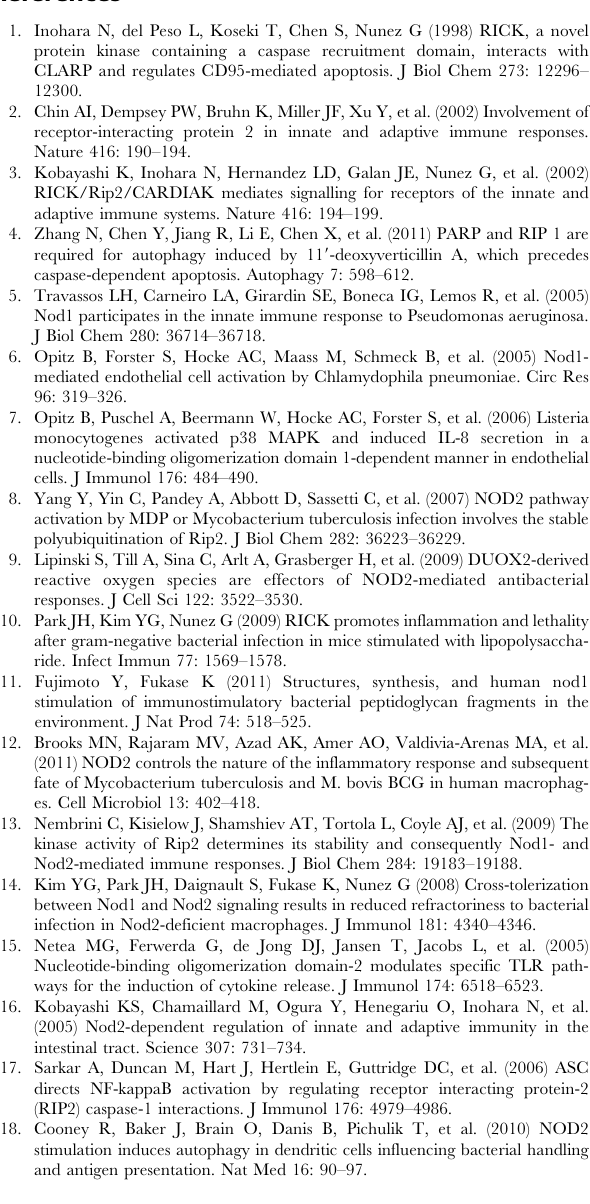
lysates were analyzed for RIPK1 (top panel) RIPK2 (mid panel), PARP (lower panel) and GAPDH (bottom panel). Full-length RIPK1 and RIPK2 are indicated with arrows. Prominent P. gingivalis -induced LMW bands are indicated with asterisks. MW ladder is indicated on the left in kDa. Figure S7 Lysine-specific gingipain (Kgp) activity me- diates P. gingivalis -induced modification of PARP in HAEC. A ) Kinetics of PARP levels in HAEC in response to P. gingivalis 381. HAEC were treated with medium ( M ) or with P. gingivalis strain 381 (MO1 100) for 0.25, 0.5, 1, 2, 6, 12, 24 or 48 h. Whole cell lysates were analyzed for the detection of PARP (116- kDa). Full-length PARP is indicated with an arrow. MW ladder is indicated on the left in kDa. GAPDH was detected as a loading control. B ) P. gingivalis strain 381 was pretreated with 10 m M